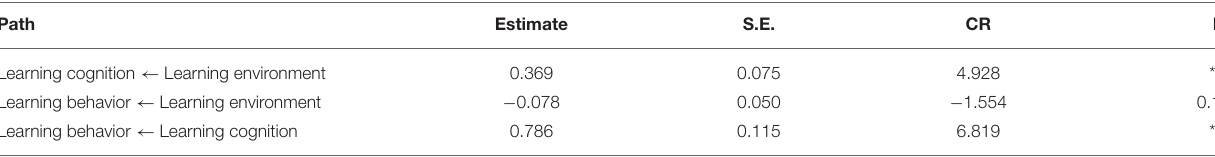
TABLE 10 | Path-effect relationship between independent, intermediate, and dependent